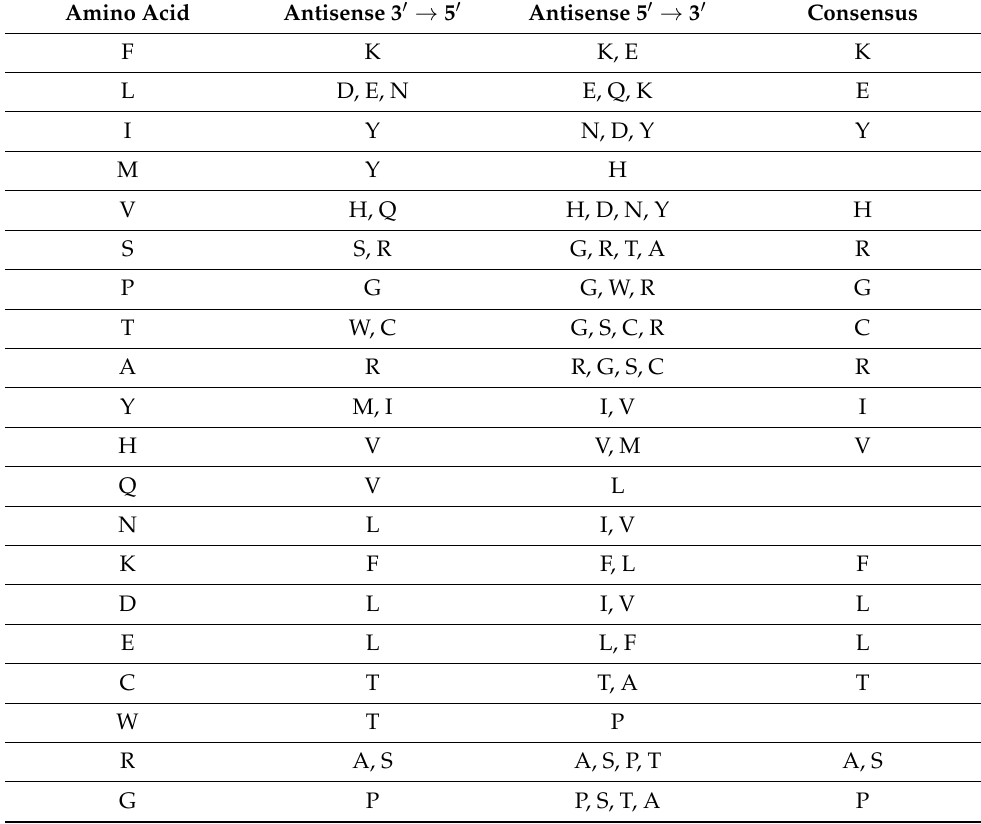
Table 2. Direction of translation specifies amino acid